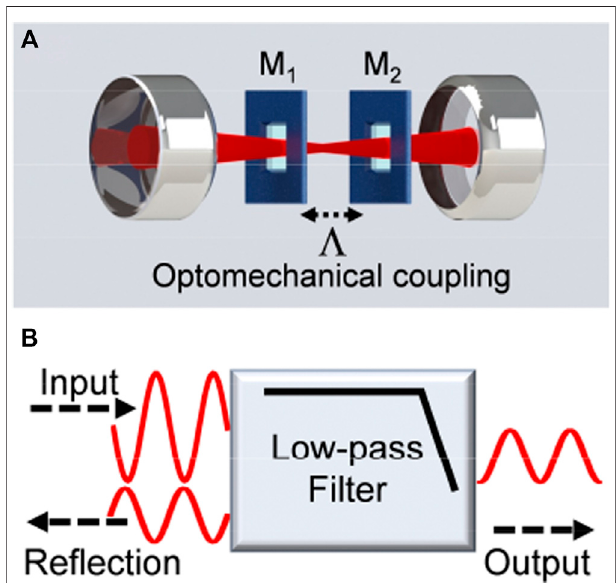
FIGURE 1 | (A) Experimental setup of the two-membrane-in-the-middle optomechanical system. M 1,2 is the membrane and Λ is effective optomechanicalcouplingbetweentwomechanicalresonators. (B) Schematic diagram of a three-terminal device as a phononic low-pass fi lter with input, re fl ection, and output